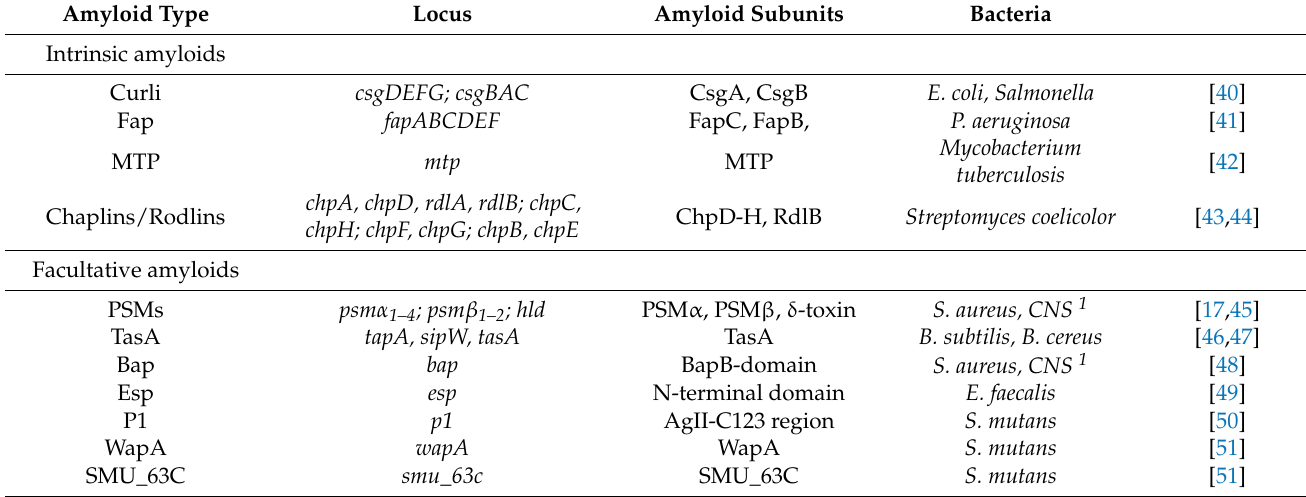
chpA, chpD, rdlA, rdlB; chpC, chpH; chpF, chpG; chpB,